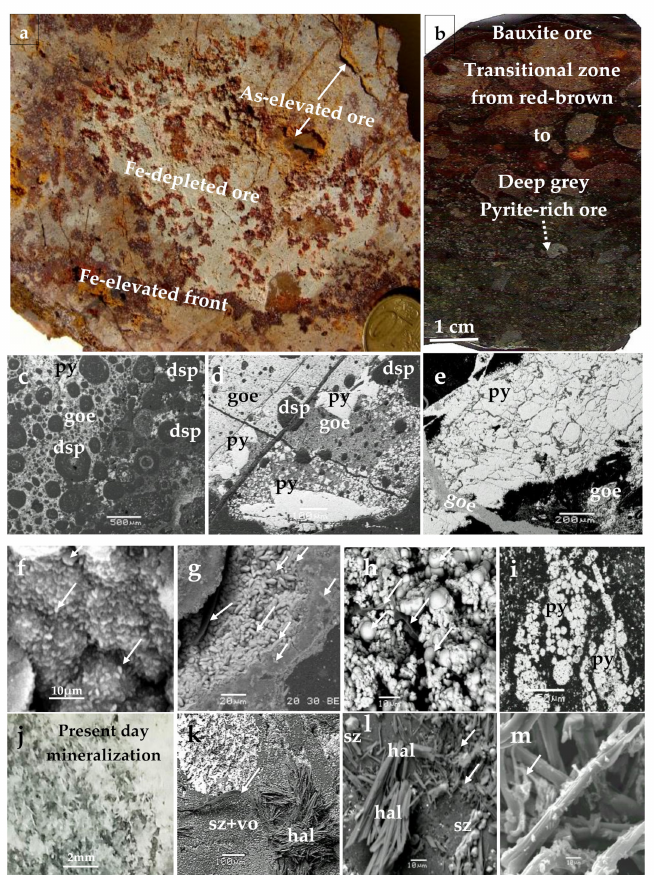
Figure 2. Photographs of hand bauxite samples from the transition zone of whitish-grey, yellow and deep red color ( a ) and a transformed red to deep grey sulfide-rich ore from the Parnassos-Ghiona bauxite deposit ( b ). Backscattered electron images (BSE) of grey-red bauxites showing pisoliths and matrix dominated by diaspore ( c ), the association of pyrite remnants with goethite ( d ), vein of pyrite crosscutting goethite and goethite vein crosscutting pyrite ( e ). The unpolished parts of the bauxite sample revealed the presence of goethite microtextures resembling variety of fossilized microorganisms coated by goethite (white arrows) ( f – i ); replacement of fine-grained framboidal pyrite by a coarser-grained pyrite and the coexistence of pyrite, either as fine-grained spherical pyrite and pyrite pseudomorphs ( h ). Present-day biomineralization on hand bauxite sample ( j ); BSE images of aggregates of hydrous sulfate minerals: halotrichite, szomolnokite, and voltaite ( k – m ) from polished sections. Abbreviations: py = pyrite; goe = goethite; dsp = diaspore; hal = halotrichite; sz =